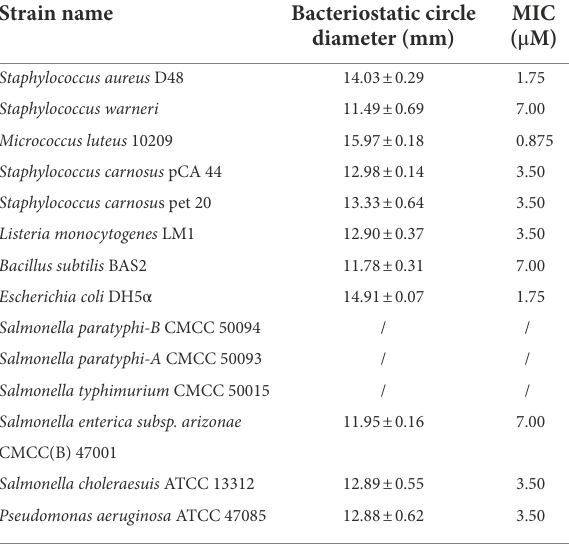
TABLE 1 Antibacterial spectrum of bacteriocin